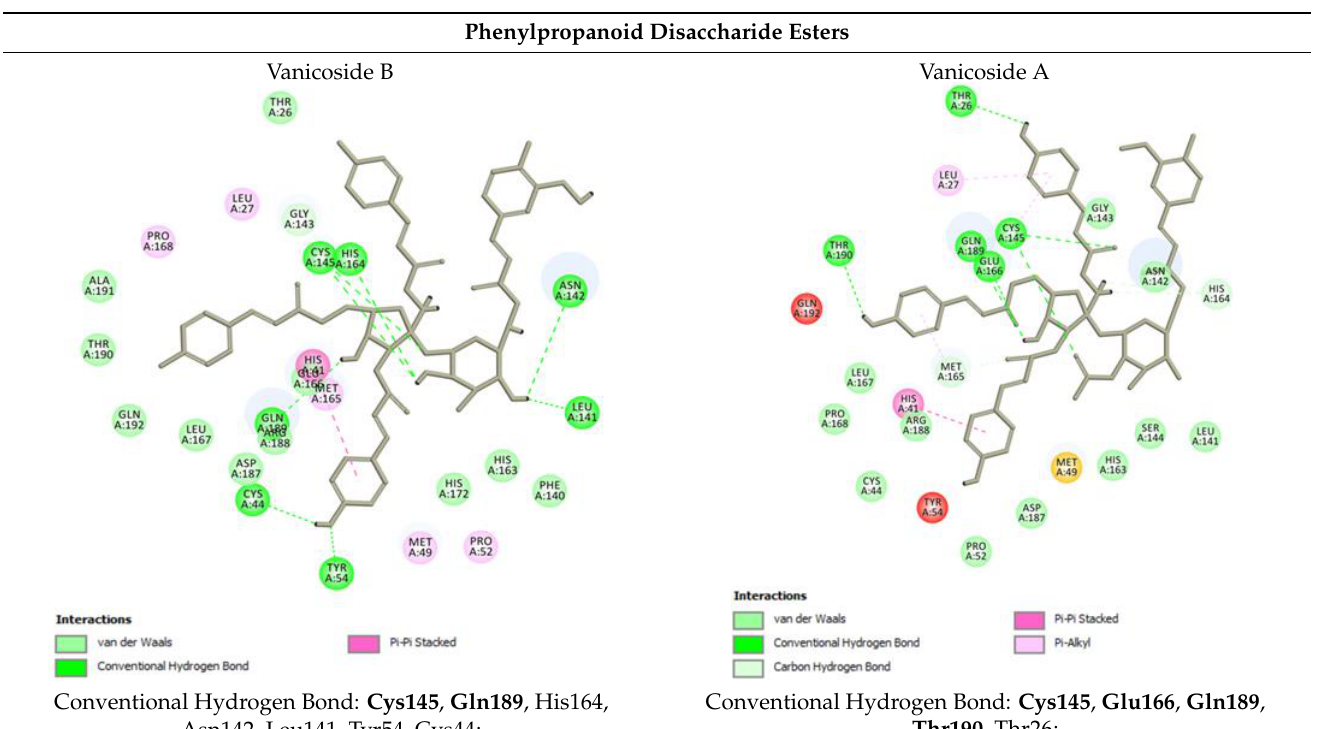
Table 1. 2D interactions diagrams of presumably good candidates for Mpro inhibitors.